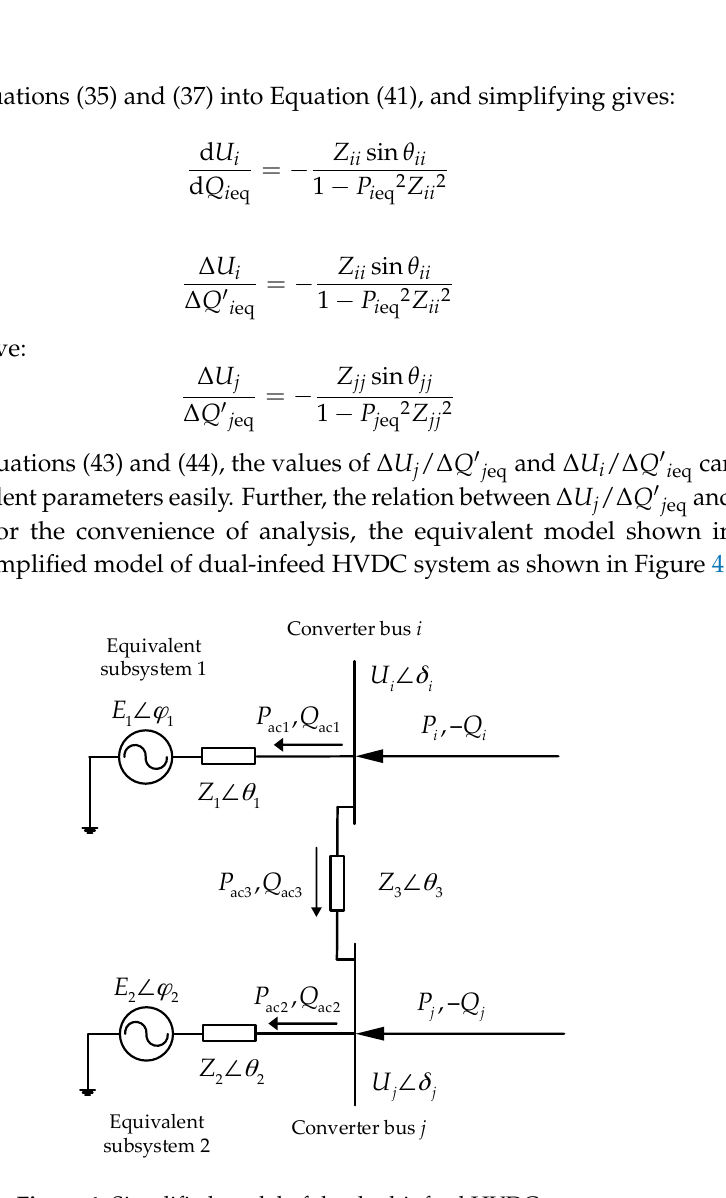
Figure 4. Simplified model of the dual-infeed HVDC system.